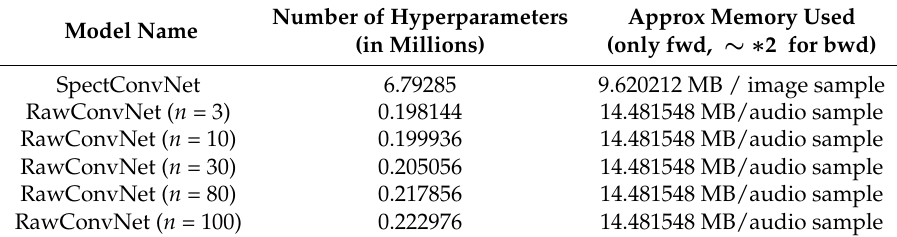
Table A1. Hyperparameters and approximate memory usage of